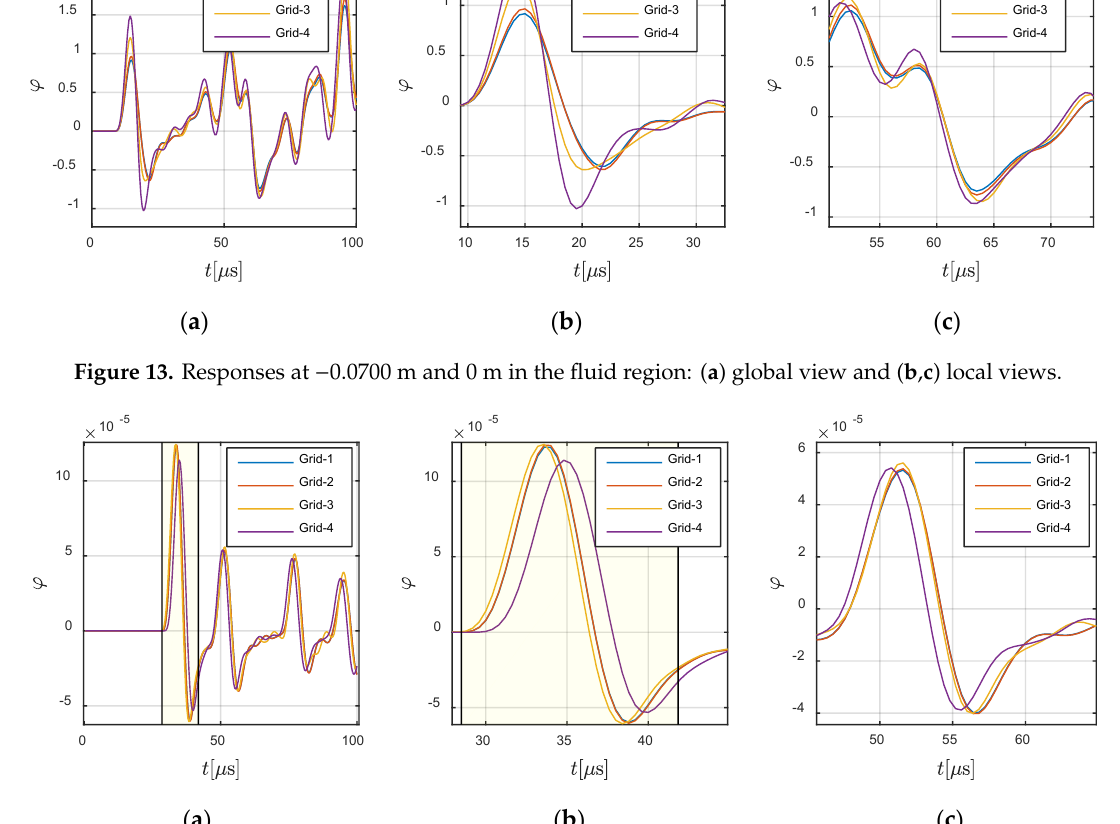
Figure 12. Responses in Y- direction at − 0.0625 m and 0 m in the solid region: ( a ) global view and ( b , c )